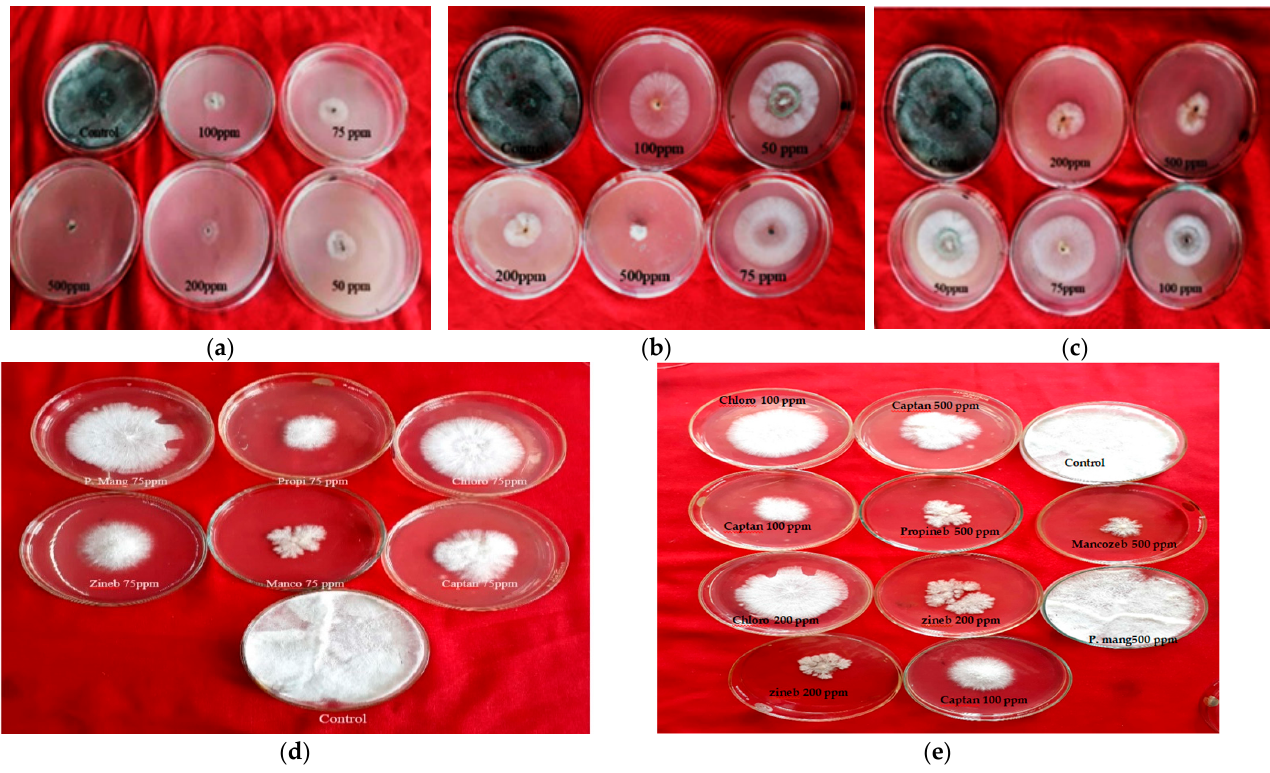
Figure 1. Effect of non-systemic fungitoxicants on radial mycelial growth of T. harzianum and A. bisporus : ( a ) Chlorothalonil fungitoxicant against T. harzianum ; ( b ) Prochloraz manganese fungitox- icant against T. harzianum ; ( c ) Captan fungitoxicant against T. harzianum ; ( d , e ) P. mang (=Prochloraz manganese), Propi (=propineb), Chloro (=chlorothalonil), zineb, Manco (= mancozeb) and captan fungitoxicant against A. bisporus.